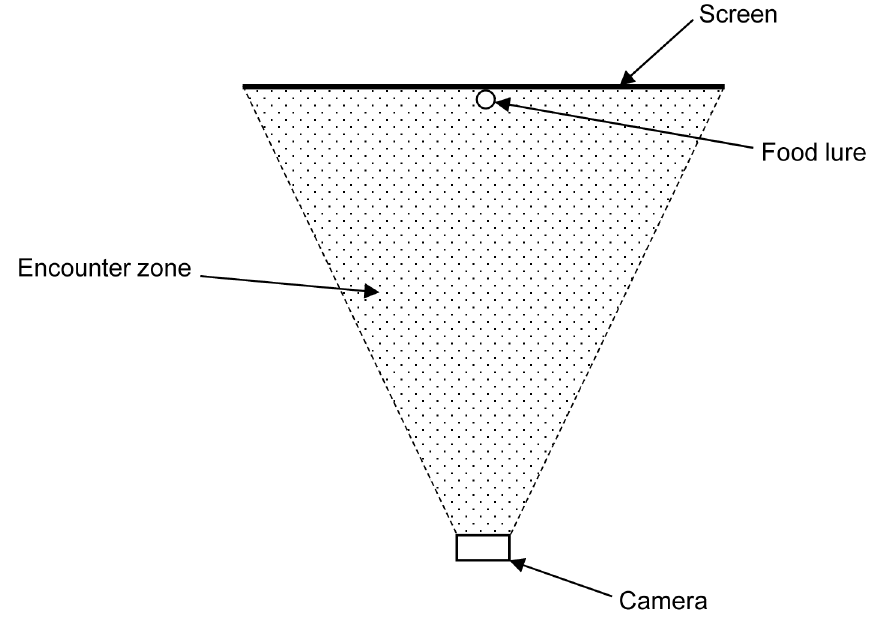
Figure 1. Overhead view of a camera trap showing the triangular zone between the camera and the shade cloth screen. An animal was deemed to have encountered the camera trap if it entered this